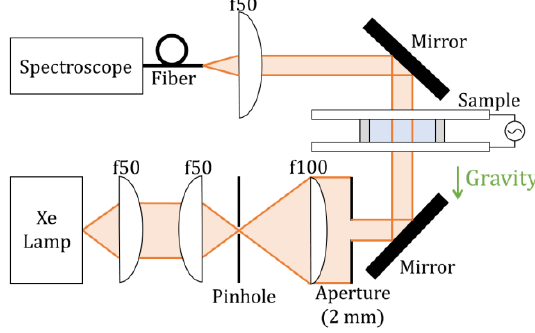
Figure 4. Optical system for measuring the change in transmittance of the suspension of silver coated hemispherical Janus particles. The applied voltage was 10 V in amplitude at 1 kHz. Light was incident normally to the ITO electrodes.